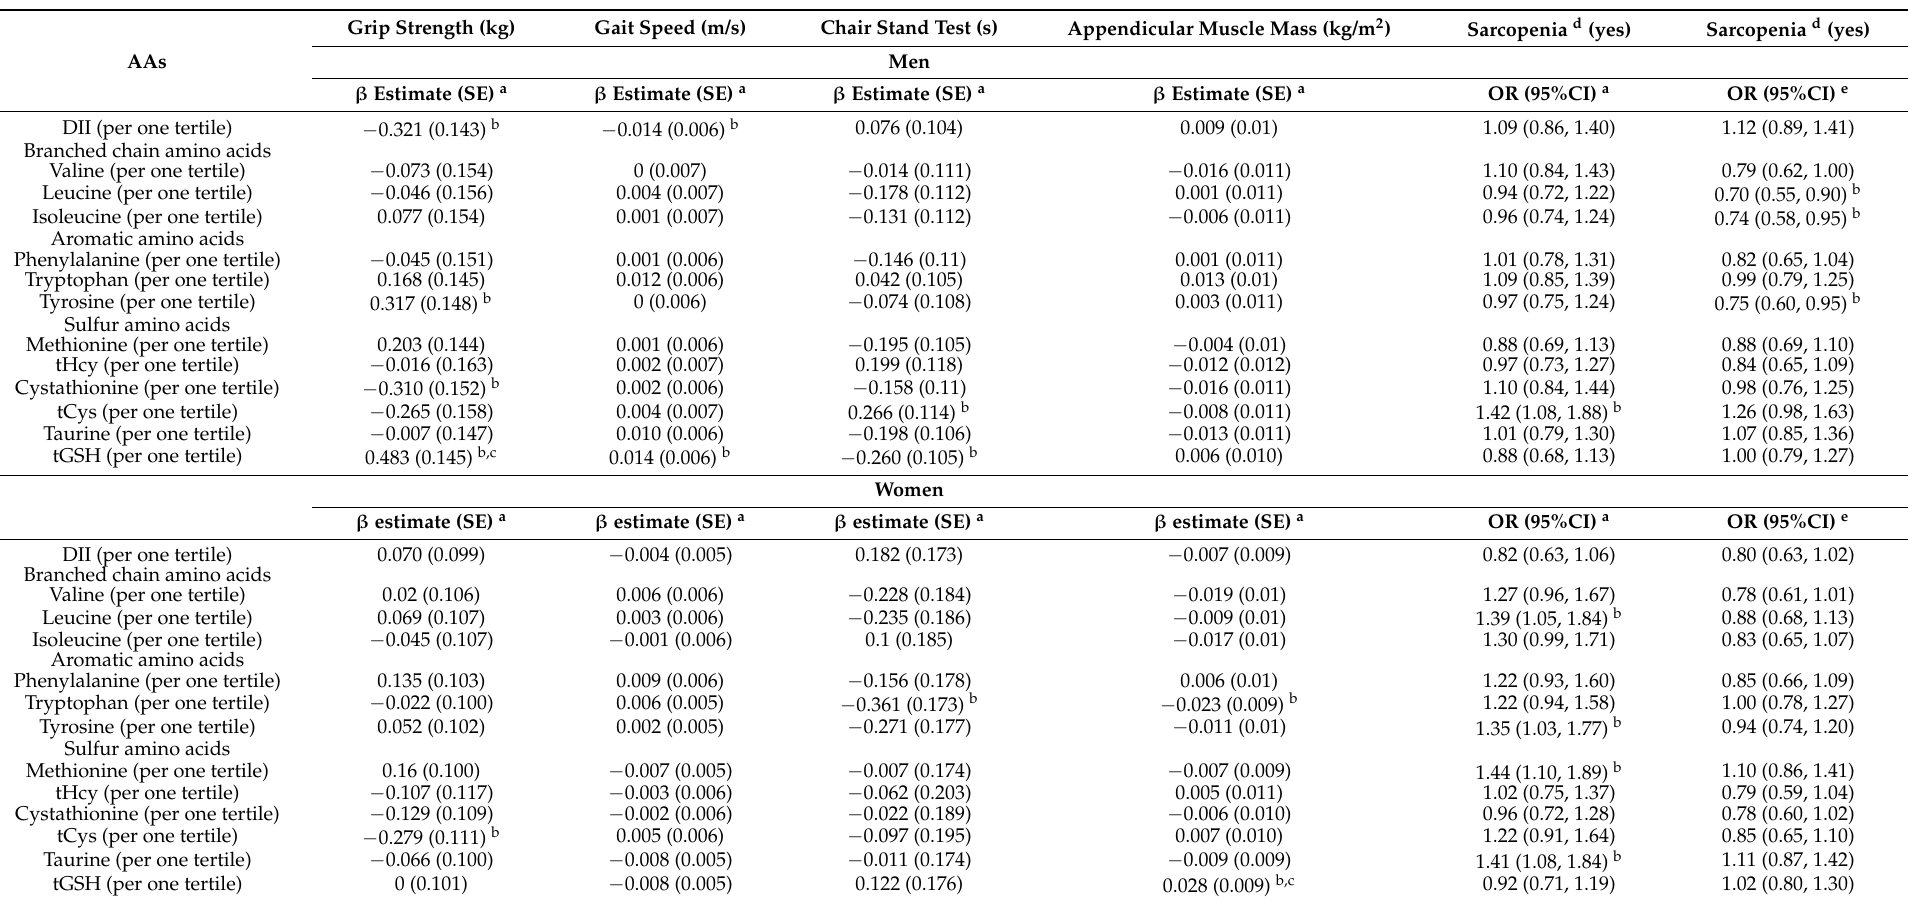
Table 3. The association of baseline serum amino acids with the changes of individual muscular parameters and incident sarcopenia over 4